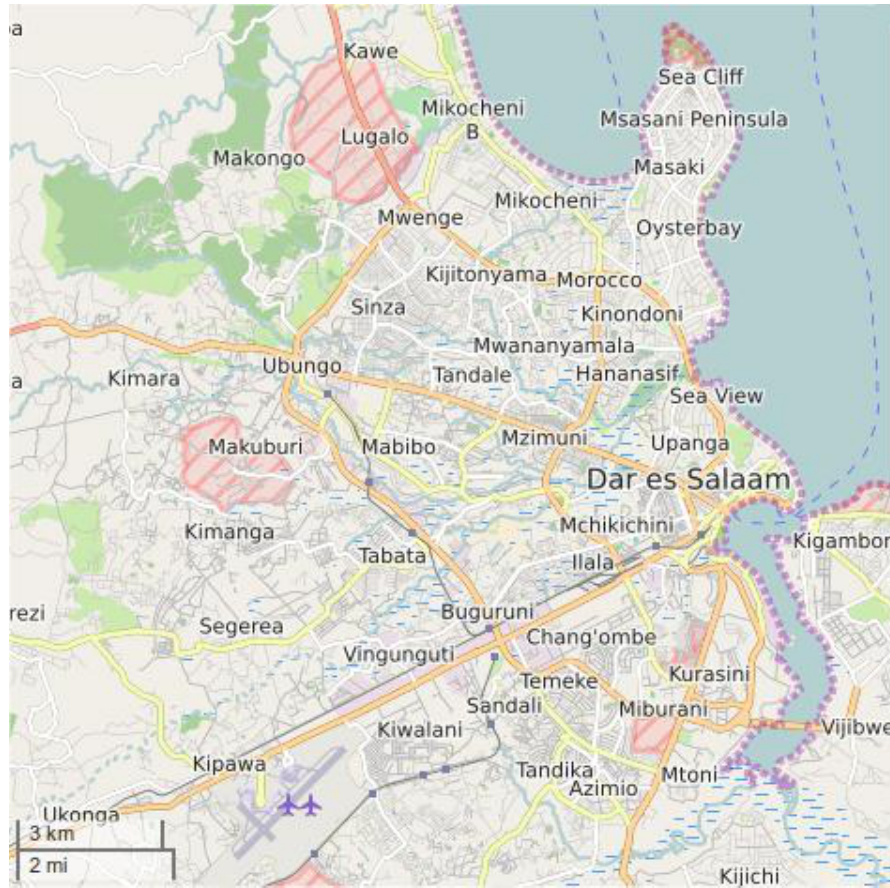
Figure 3. Location of the study are in Dar es Salaam, Tanzania. Copyright: © OpenStreetMap contributors.